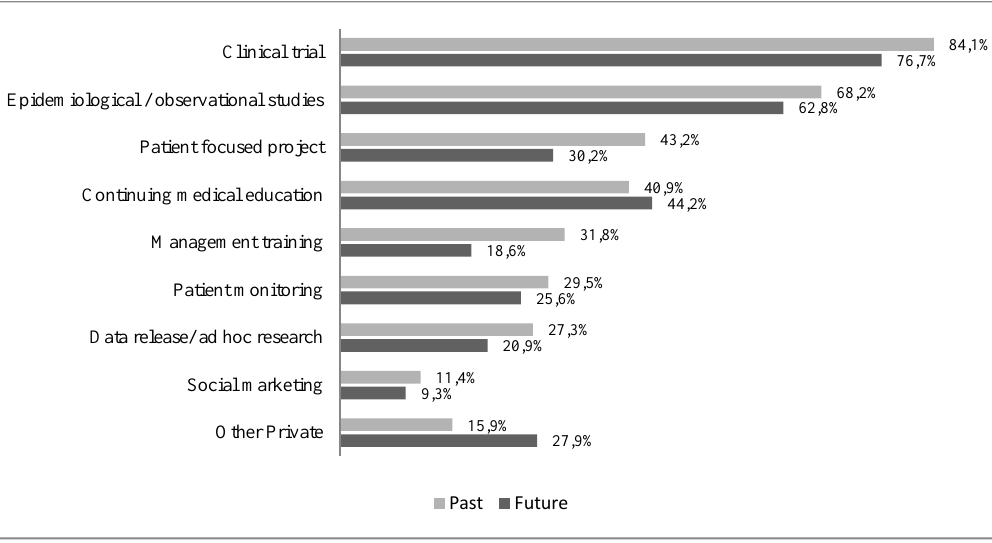
Source: Research Centre B-ASC. Based on research